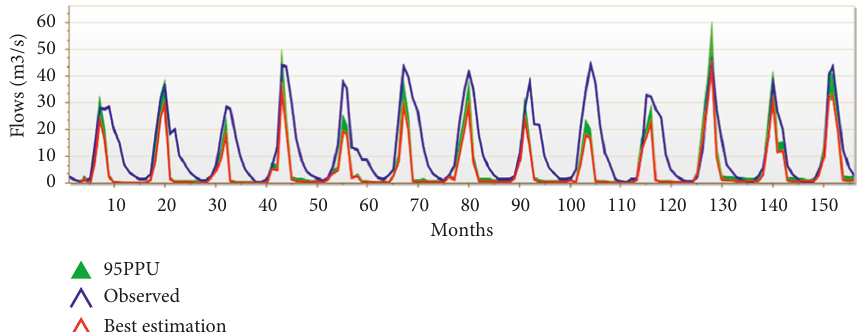
Figure 5: Calibration of streamflow result by RCA4